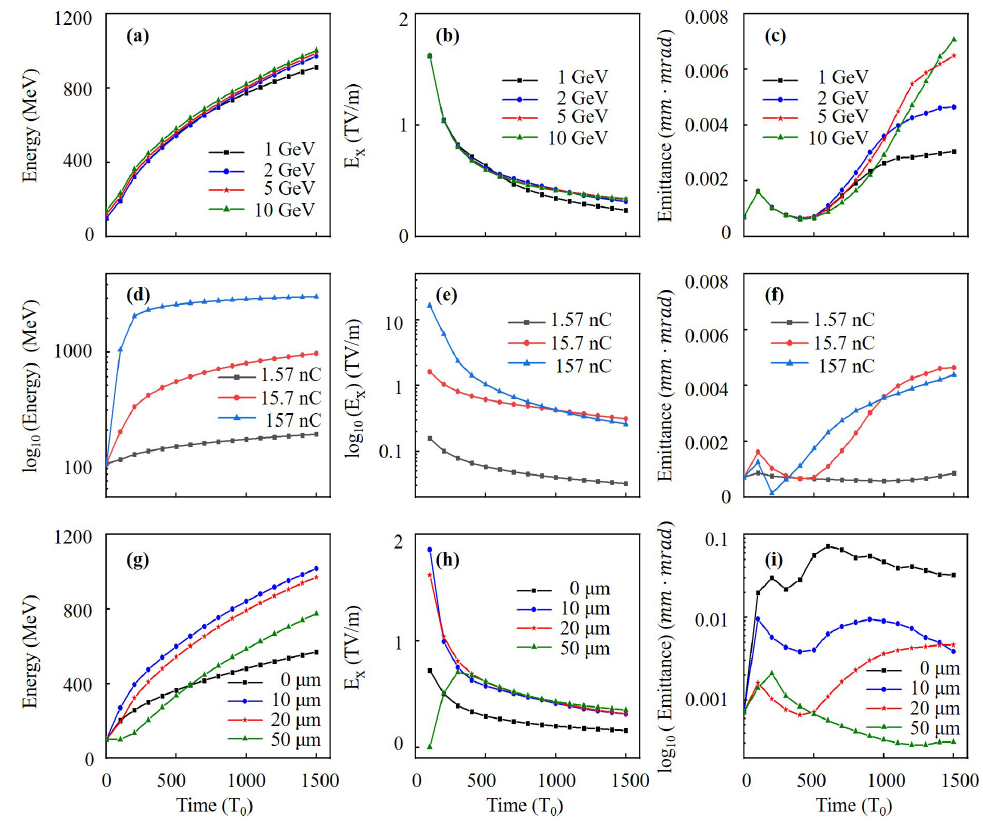
Figure 5. Time variations of ( a ) average positron energies, ( b ) acceleration gradient and ( c ) geometric emittance at different drive beam energies. Time variations of ( d ) average positron energies, ( e ) ac- celeration gradient and ( f ) geometric emittance at different drive beam density. Time variations of ( g ) average positron energies, ( h ) acceleration gradient and ( i ) geometric emittance at different drive beam